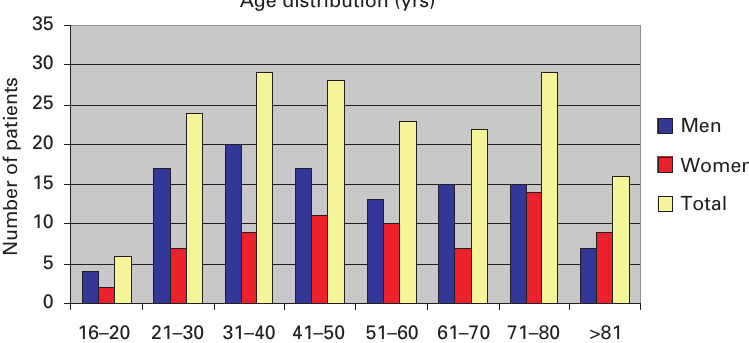
Age distribution for occurrence of first